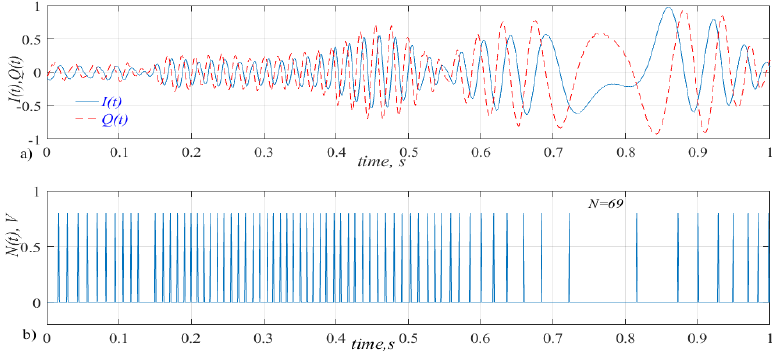
Fig. 3. Diagrams of the signals at the outputs of the quadrature mixer I ( t ) and Q ( t ) - a), and the pulses at the output of the comparator N i (t) -